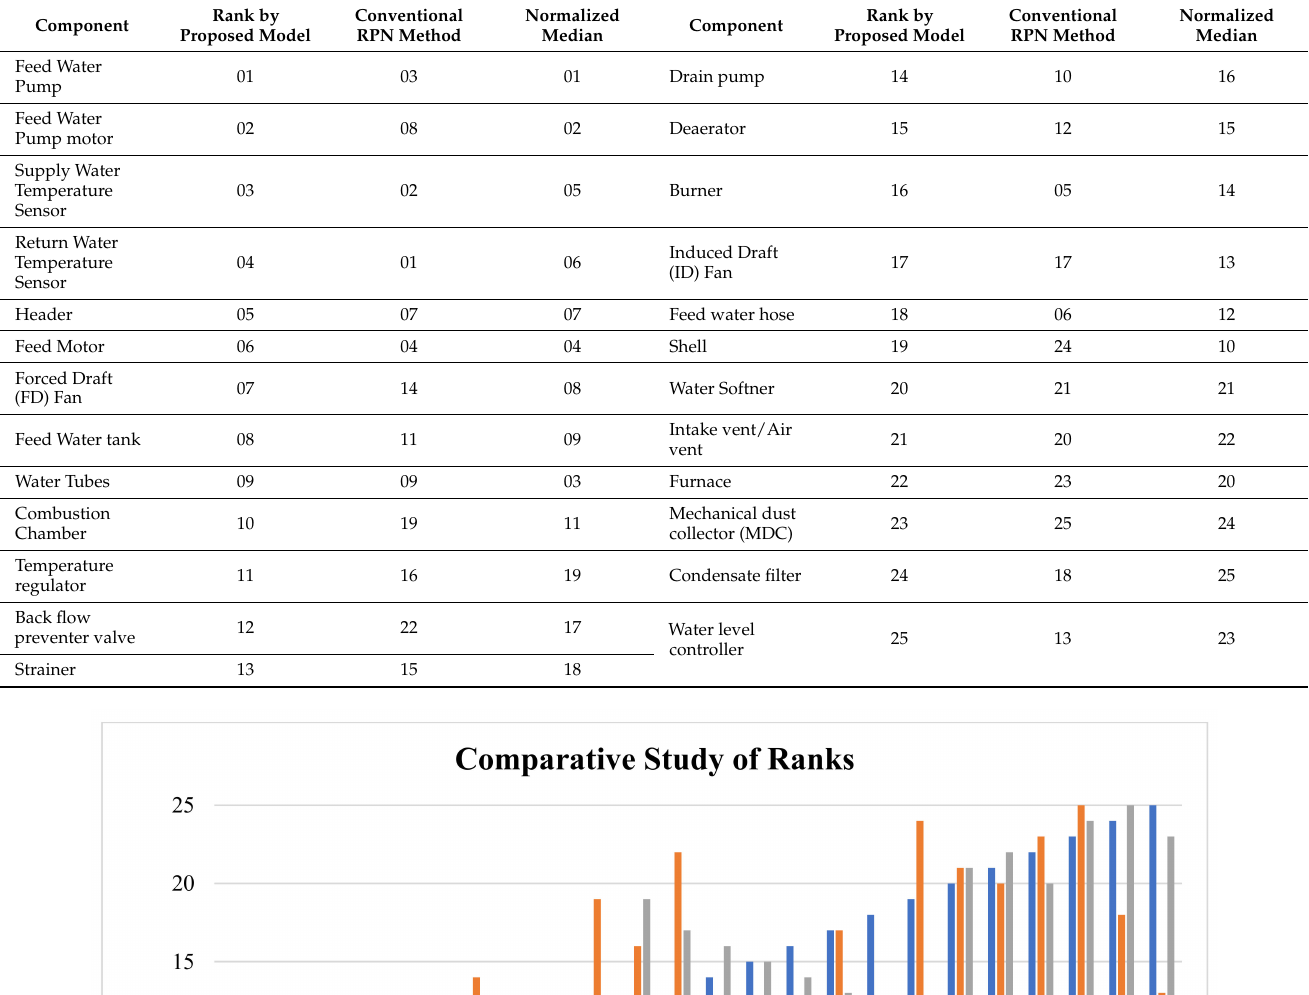
Table 13. Comparative analysis by Proposed Model, Conventional RPN, and Normalized Median method.